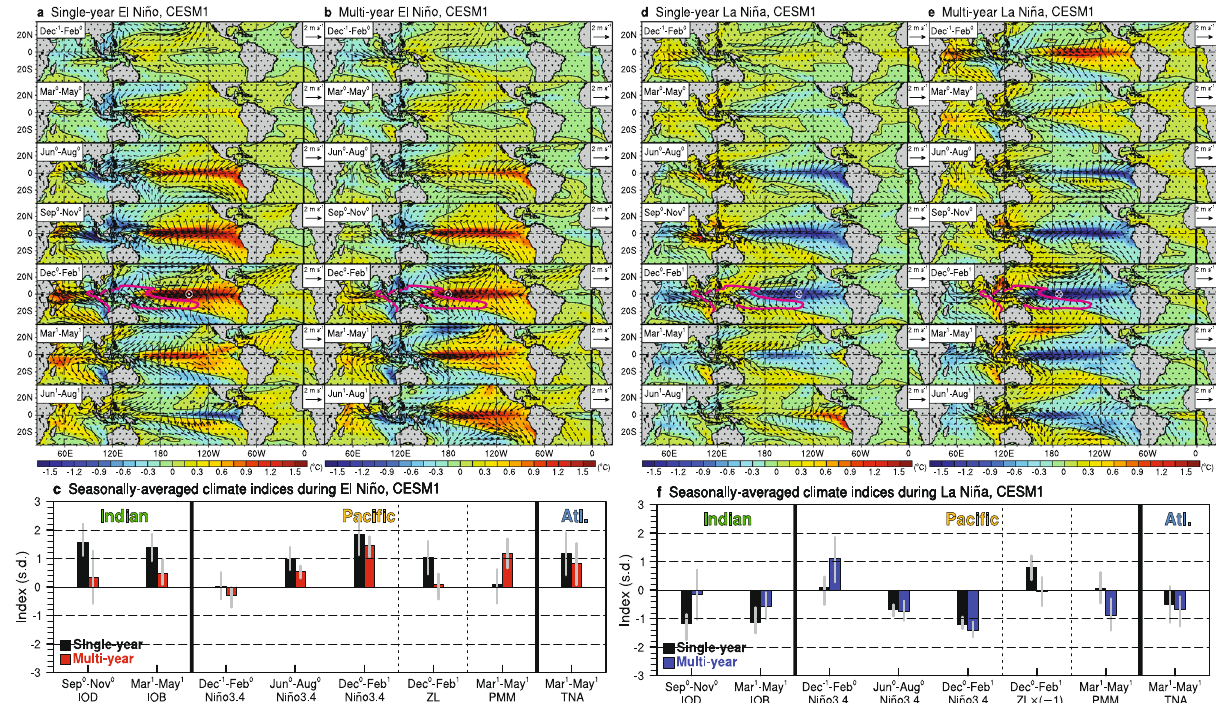
Fig. 2 Selective activations of pantropical climate interactions during single- and multi-year ENSO events. Composite seasonal structures of anomalous SST (shading; zero values expressed in black contour) and surface wind (vector) over the entire tropics for the a single- and b multi-year El Niños in the CESM1 during their preceding winter (i.e., December -1 to February 0 ), developing spring (i.e., March 0 to May 0 ), summer (i.e., June 0 to August 0 ), fall (i.e., Septemper 0 to November 0 ), peak winter (i.e., December 0 to February 1 ), decaying spring (i.e., March 1 to May 1 ), and summer (i.e., June 1 to August 1 ). The magenta contours and circled/crossed dots for El Niño/La Niña during the peak winter represent climatological 28°C isotherm line and longitudinal position of the maximum SSTAs, respectively. c Bar-chart displaying seasonally- averaged climate indices of IOD, IOB, Niño3.4, ZL, PMM, and TNA for the single (black bar-chart) and multi (red bar-chart)-year El Niños (see Methods for the index de fi nitions). All the indices are normalized by their standard deviations and the gray bars indicate their interquartile ranges (that is, the 75 th percentile minus the 25 th percentile; see Methods). d – f Same as a – c , respectively, except for single- and multi-year La Niñas. In f , the bar-charts displaying multi-year La Niña are expressed in blue and the ZL index is multiplied by − 1, so that its increasing (decreasing) value corresponds to a more eastward (westward)-centered La Niña